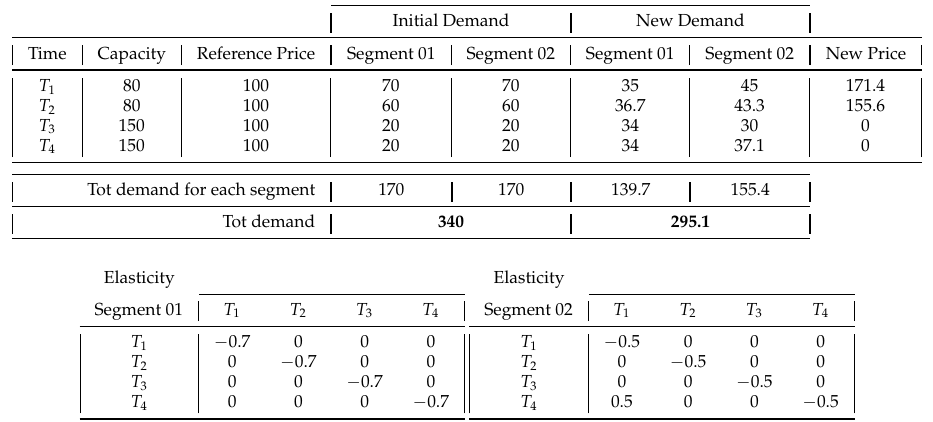
Table 7. Case Study 6.02—second sub-case, data, and results.